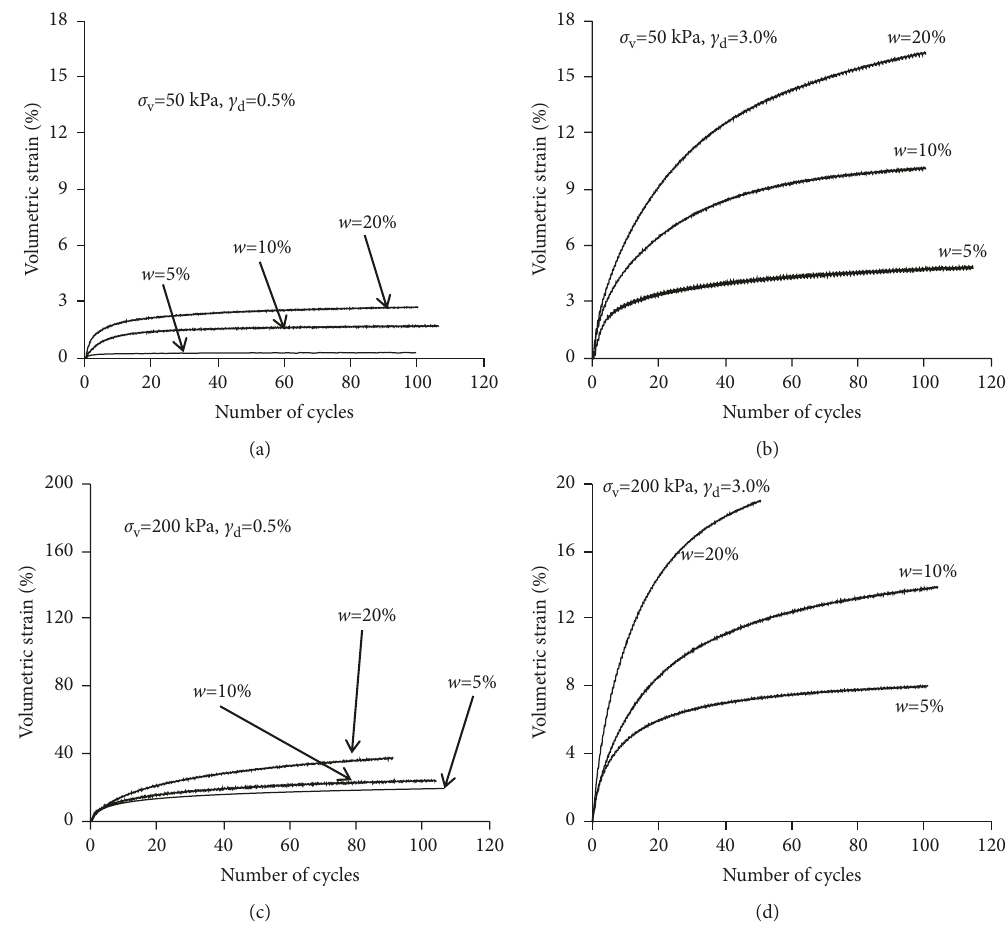
Figure 7: Stress-strain curves of intact loess under different water